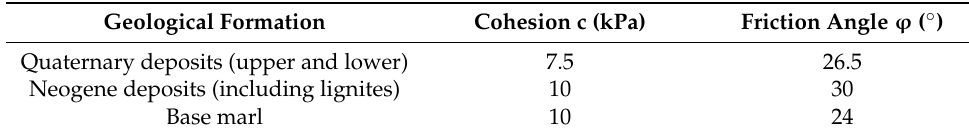
Figure 11. Geological Sections A ( top ) and B ( bottom ). Section A: Height 200 m (from +390 to +590) and average inclination 1:4. Section B: Height 200 m (from +400 to +600) and average inclination 1:7 (due to the 2017 landslide that accumulated most of the Fill material shown on the surface of the slope). Table 1. Geotechnical parameters used in the stability